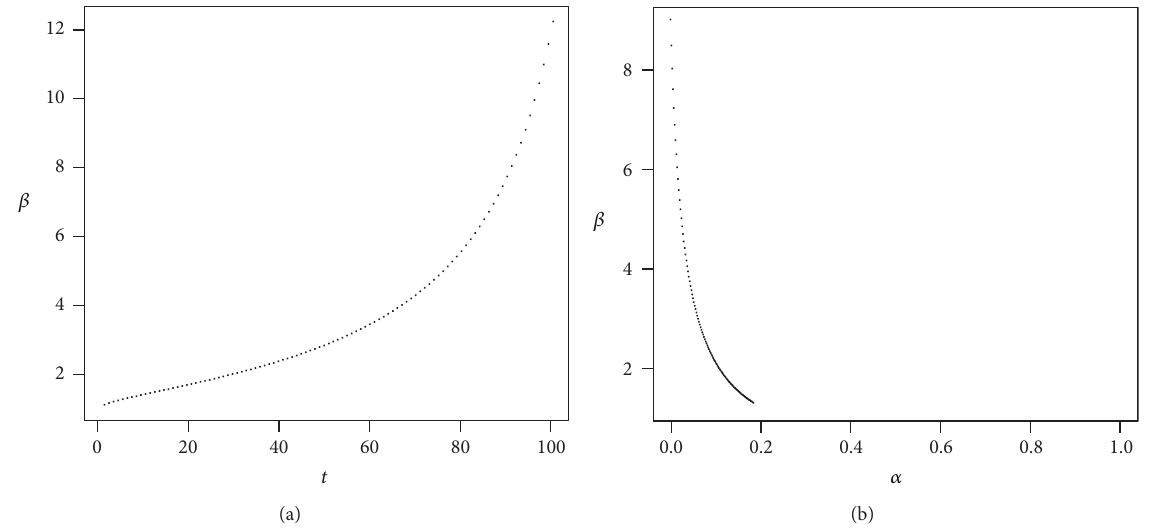
Figure 8: High volatility of returns (pessimistic). The plot shows 𝛽 as a function of 𝑡 with 𝛼 = 50 % (a) and 𝛽 as a function of 𝛼 with 𝑡 = 40 (b). Parameters are 𝑟 = 4 %, 𝜇 = 17.5 %, 𝜎 = 75 %, ] = 3.1 %, and 𝛾 = 10